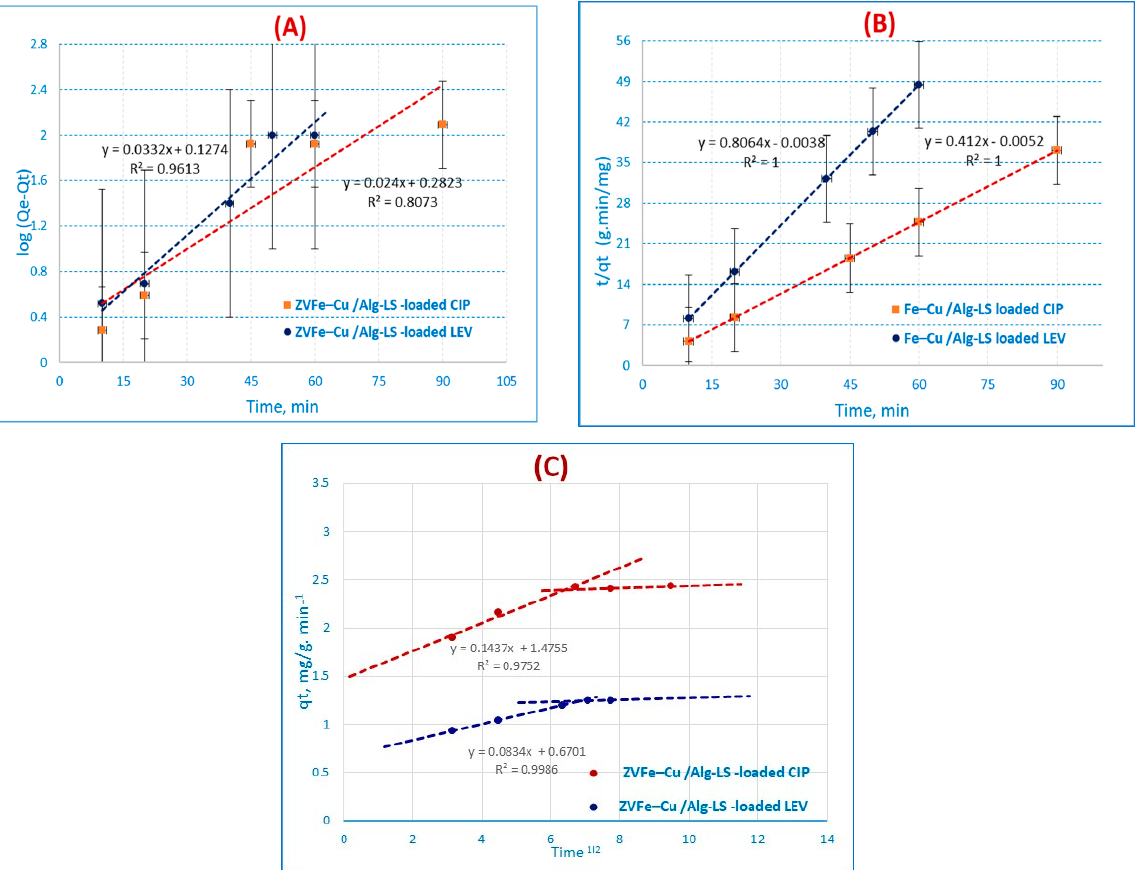
Figure 7. Adsorption kinetics: ( A ) pseudo-first-order reaction (PFORE), ( B ) pseudo-second-order reaction (PSORE), ( C ) Morris–Weber equation for CIP and LEV on the Fe–Cu/Alg–LS nanocomposite (sorption time, (40 min (CIP) 45 min. (LEV) by 0.2 g/25 mL of the nanocomposite at pH 6 (CIP) and 7 (LEV).